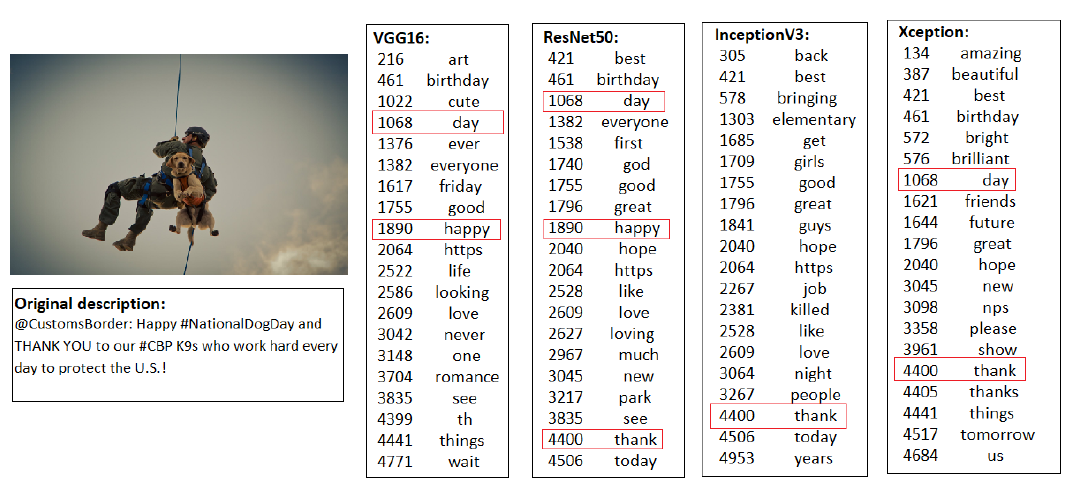
Figure 9. Text for Sentiment Analysis data set: Comparison between original and generated description using different types of image features. Similar descriptors are marked in red